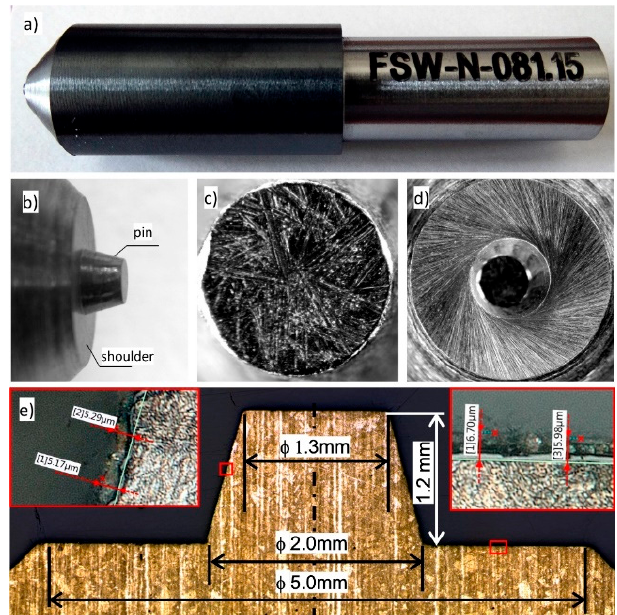
Figure 1. Friction stir welding (FSW) tool with the AlCrN coating used for wear tests: ( a ) tool, ( b ) tool working parts, ( c ) frontal surface of a pin, ( d ) shoulder surface, ( e ) cross-section of the tool.